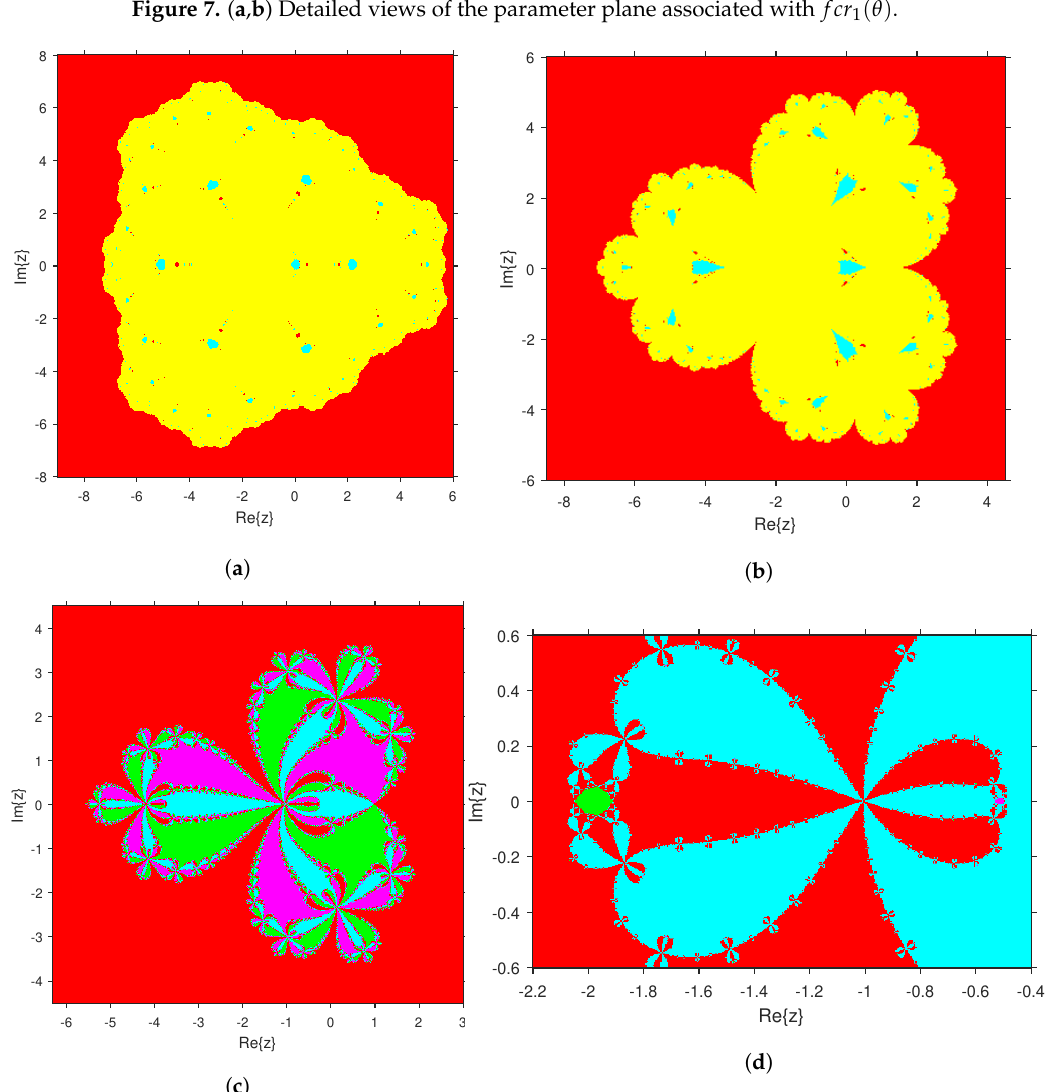
Figure 8. Dynamical Planes. ( a ) θ = 44.5, ( b ) θ = − 22, ( c ) θ = − 10, ( d ) θ =